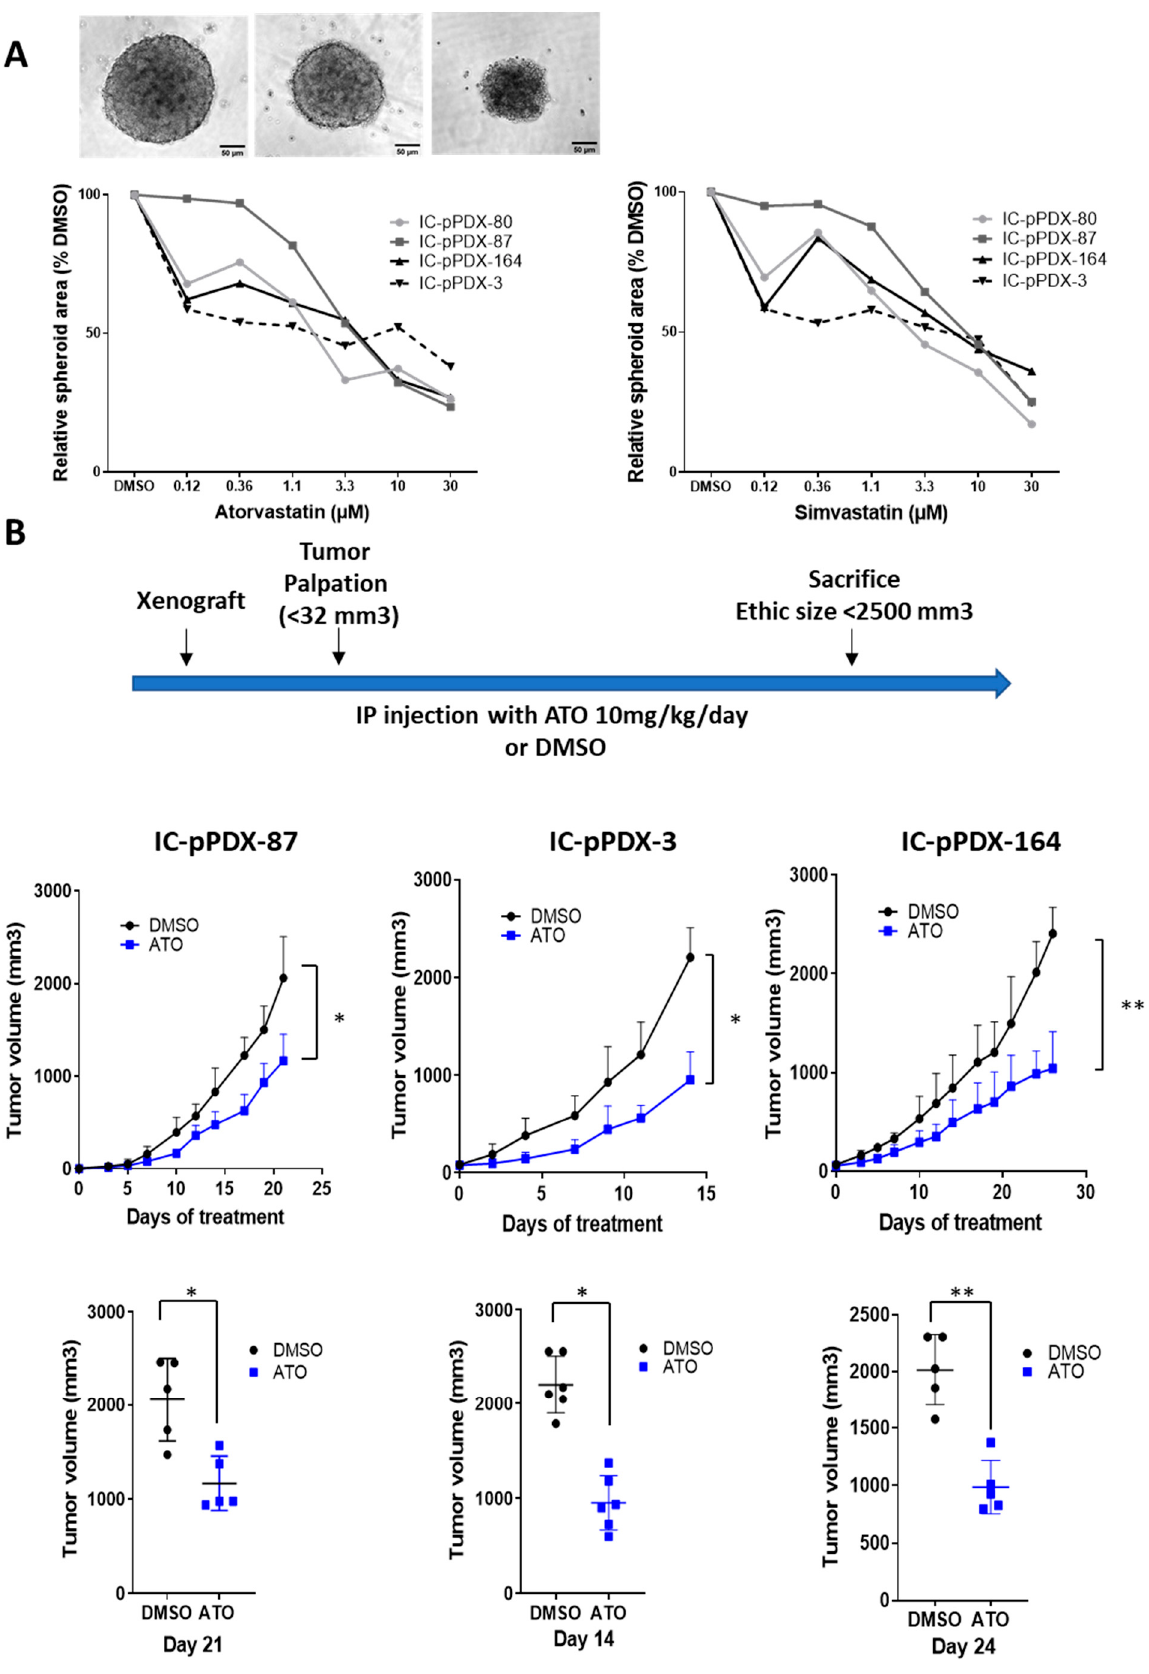
Figure 6. Statins induce a decrease in 3D spheroid growth and impair tumor growth of Ewing sarcoma PDX. ( A ) Representative images and dose–response curves showing the spheroid area relative to